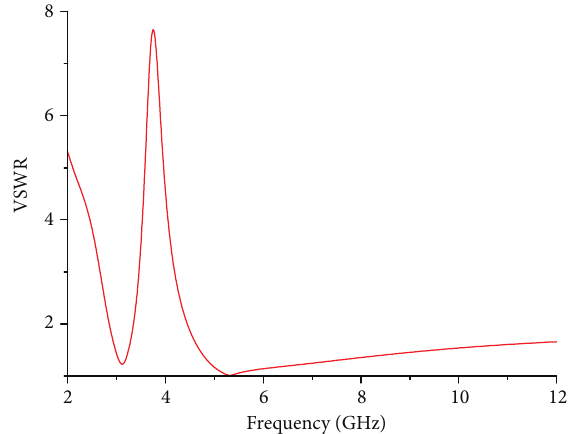
Figure 4: Simulated VSWR of the single band-notched antenna.